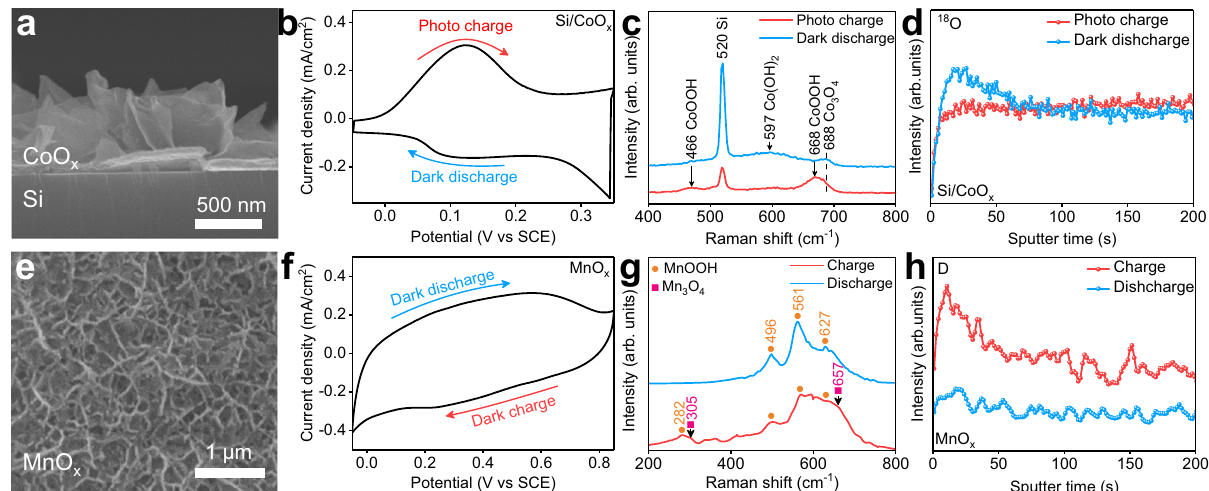
Fig. 1 Characterization of Si/CoO x photoelectrodes and MnO x counter electrodes. a Cross-sectional SEM of Si/CoO x . b CV curve of a Si/CoO x photoelectrode at the scan rate of 10 mVs − 1 during photo charge and dark discharge. c Raman spectra of Si/CoO x . d TOF-SIMS spectra of 18 O depth pro fi le in Si/CoO x . e Surface SEM image of MnO x . f CV curve of a MnO x counter electrode at the scan rate of 10 mVs − 1 in the dark. g Raman spectra of MnO x . h TOF-SIMS spectra of D depth pro fi le in MnO x . Light source: 1 Sun of simulated solar illumination by a Xe lamp with AM 1.5G fi lter (100 mWcm − 2 ), electrolyte: KBi aqueous solution (0.2 M KOH and 0.4 M H 3 BO 3 ) with pH = 9.